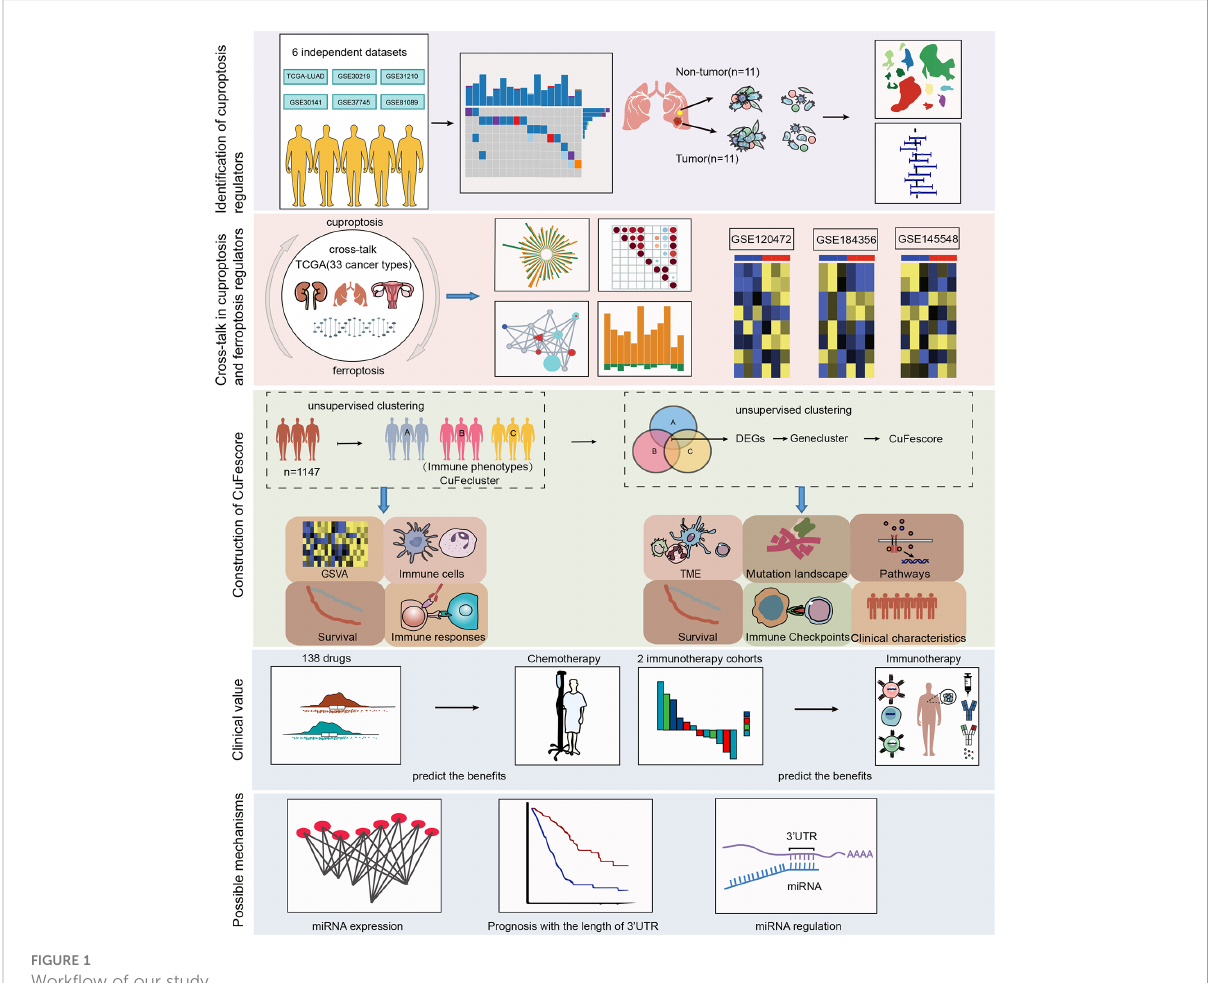
FIGURE 1 Work fl ow of our